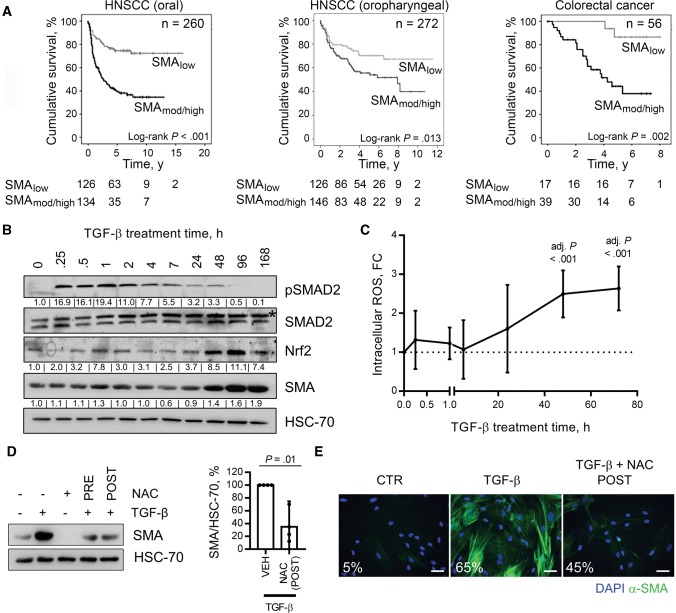
Myofibroblast stroma and survival in cancer and analysis of fibroblast-to-myofibroblast transdifferentiation. A) Kaplan-Meier plots of cancer-specific survival rates in patients, with tumor types as indicated (head and neck squamous cell carcinoma), stratified by stromal α-smooth muscle actin (SMA) expression measured by immunohistochemistry. B and C) Human fetal foreskin fibroblasts (HFFF2s) treated with transforming growth factor (TGF)–β (2 ng/mL) for the indicated time periods. B) Immunoblotting (densitometry quantification shown for α-SMA and Nrf2/HSC-70 and pSMAD2/SMAD2(Total)). C) Flow cytometry analysis of dichlorofluorescein-diacetate (DCFH-DA) fluorescence. Data are presented as mean +/− 95% confidence intervals from three independent experiments; statistical significance is shown by one-way analysis of variance with Dunnet’s multiple comparison test relative to the untreated control. D and E) HFFF2s and primary oral fibroblasts treated with TGF-β (2 ng/mL; 72 hours) +/− NAC (5 mM) administered either one hour prior to TGF-β treatment (PRE) or 24 hours after (POST). D) Immunoblotting for α-SMA expression. A representative blot is shown with densitometry quantification (mean +/− 95%CIs from four independent experiments; statistical significance was assessed by two-tailed t test with Welch’s correction). E) Immunofluorescent cytochemistry staining for α-SMA. The percentage of cells positive for α-SMA stress fibers in each condition is also shown. Scale bar represents 50 µm (E). Please see Supplementary Figure 1 (available online) for further information. HNSCC = head and neck squamous cell carcinoma; NAC = N-acetyl cysteine; POST = 24 hours after to TGF-β treatment; PRE = one hour prior to TGF-β treatment; SMA = smooth muscle actin; TGF = transforming growth factor.